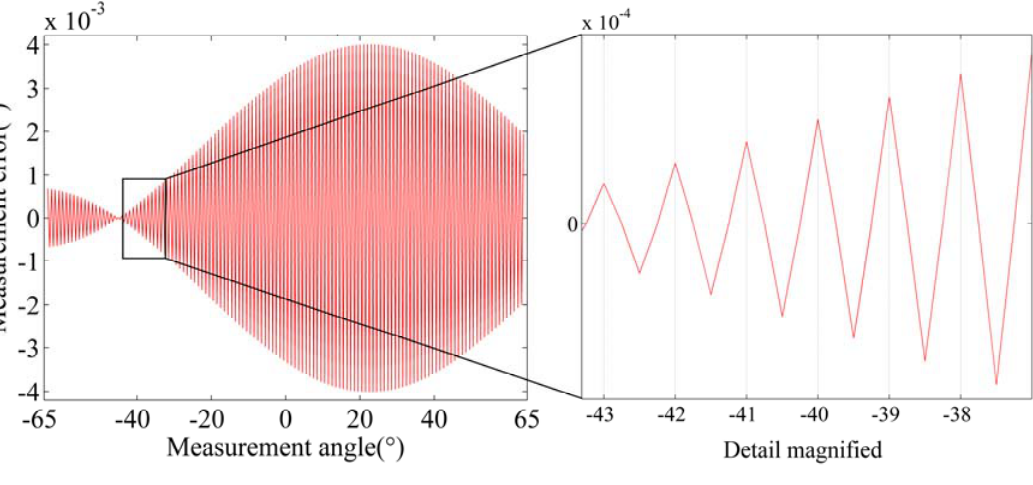
Figure 7. Measurement error caused by tilt deviation when simulated at 0.5°